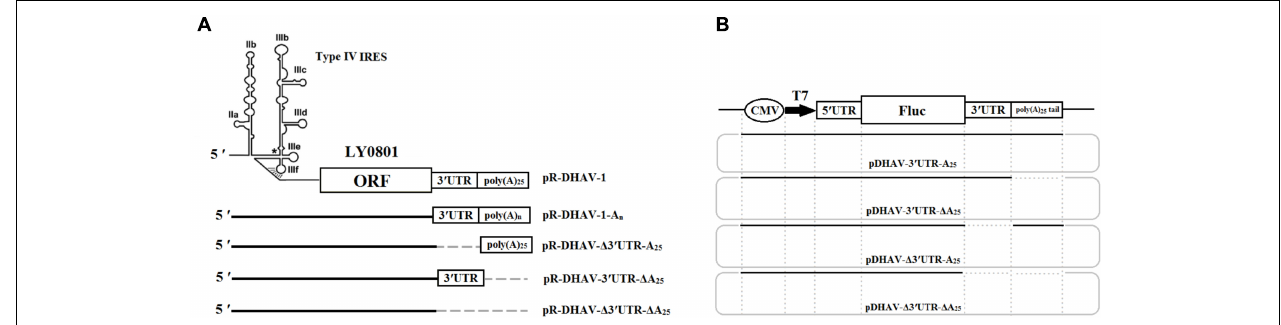
FIGURE 1 | Plasmids construction. (A) RNA-launched infectious clones absent/present poly(A) tail or 3 (cid:48) UTR were established. Besides, the mutated RNA-launched infectious clones possessed various length of poly(A) tail were also constructed and named pR-DHAV-A n ( n = 0, 5, 10, 15, 20, 25, 30, and 40). (B) Construction of the DHAV-1 monocistronic reporter system. The plasmid pDHAV-3 (cid:48) UTR-A 25 contains the following elements 5 (cid:48) to 3 (cid:48) in a pcDNA3.1/V5-His A vector: the CMV immediate early promoter, a T7 promoter, the entire DHAV-1 5 (cid:48) UTR (nucleotides 1–626, strain LY0801), and the FLuc gene and the entire DHAV-1 3 (cid:48) UTR followed by a poly(A) tail containing 25 adenines. pDHAV- (cid:49) 3 (cid:48) UTR- (cid:49) A 25 , or pDHAV-3 (cid:48) UTR- (cid:49) A 25 , or pDHAV- (cid:49) 3 (cid:48) UTR-A 25 were obtained from pDHAV-3 (cid:48) UTR-A 25 to remove 3 (cid:48) UTR plus poly(A) tail, or poly(A) tail, or 3 (cid:48) UTR, respectively. The mutated monocistronic reporter plasmids possessed various length of poly(A) tail was constructed and named as pDHAV-3 (cid:48) UTR-A n ( n = 0, 5, 10, 15, 20, 25, 30, and